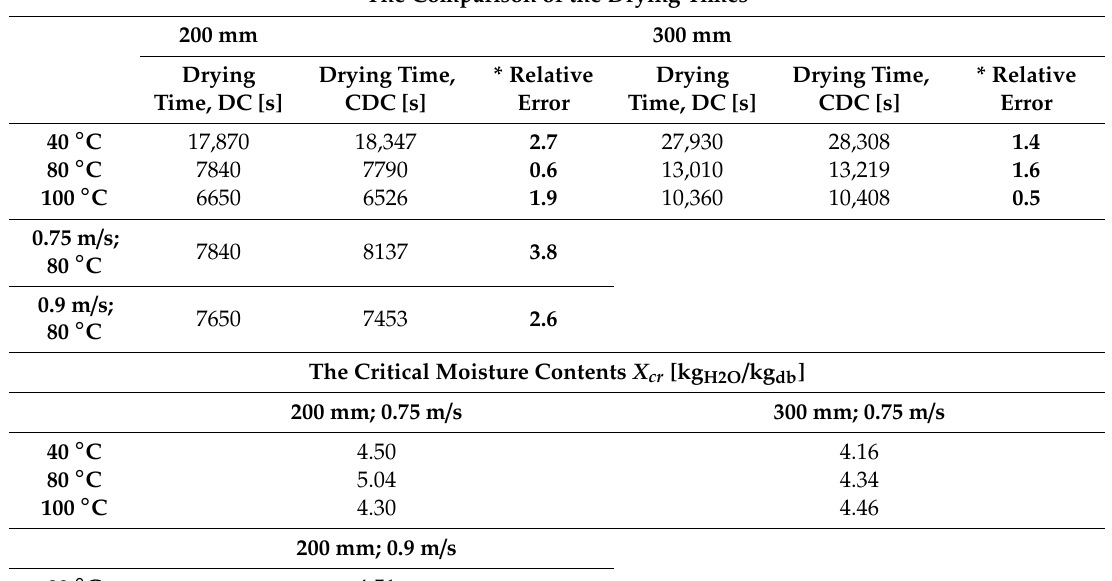
Table 2. The comparison of the experimentally measured drying times (DC), and the calculated drying times using the characteristic drying curves (CDC). Initial and final moisture contents have been 5.3